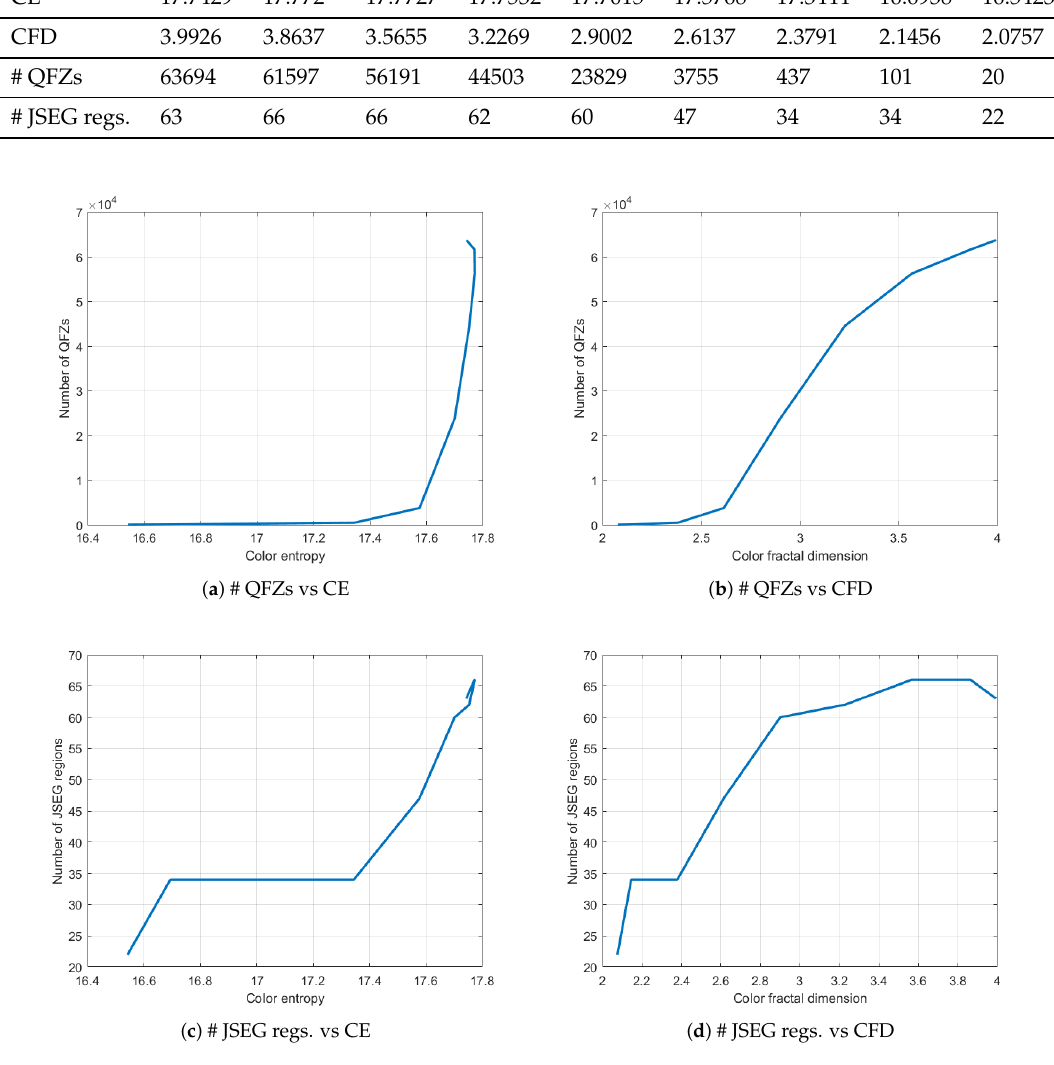
Figure 3. Plots of the number of QFZs and JSEG regions versus color entropy and color fractal dimension, respectively, for the fractal images in Figure